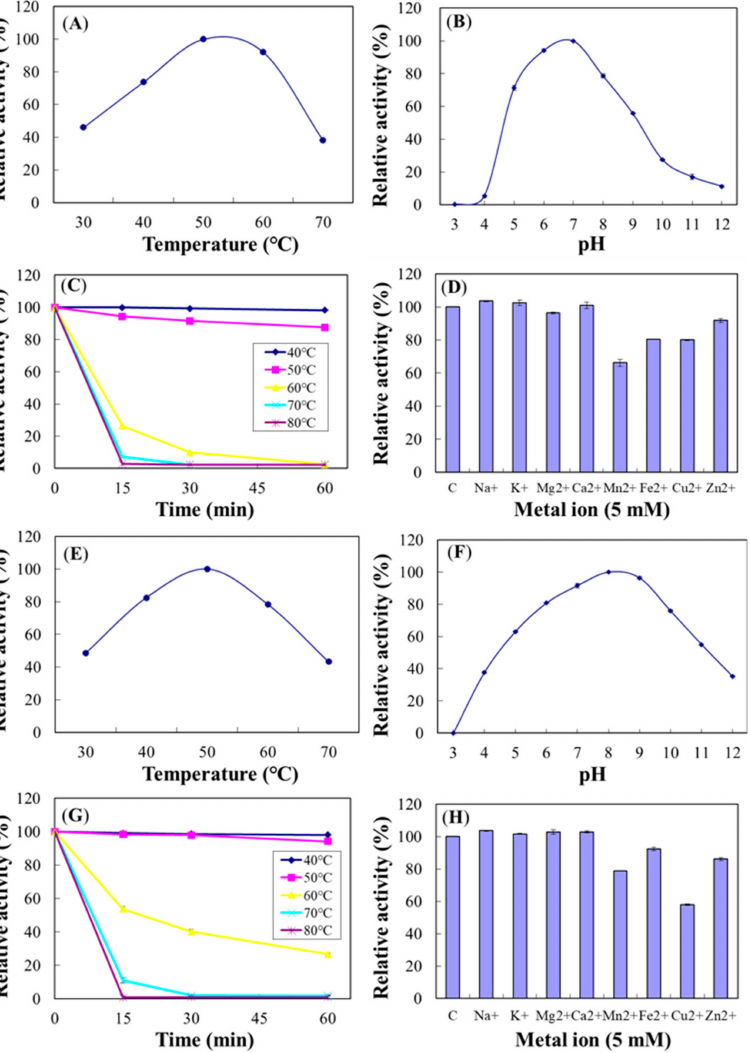
Figure 18. Characterization of Chi18C ( A – D ) and Chi18D ( E – H ). Effects of temperature ( A , E ), pH ( B , F ), thermostability ( C , G ), and metal ions ( D , H ) on purified Chi18C and Chi18D activities. The properties were characterized using the DNS method with colloidal chitin as a